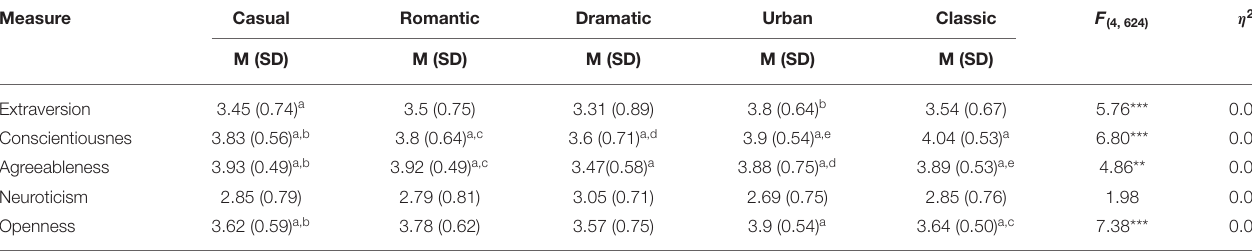
TABLE 3 | One-way ANOVA for testing the Big Five personality traits and clothing styles ( N = 792). Measure Casual Dramatic Urban